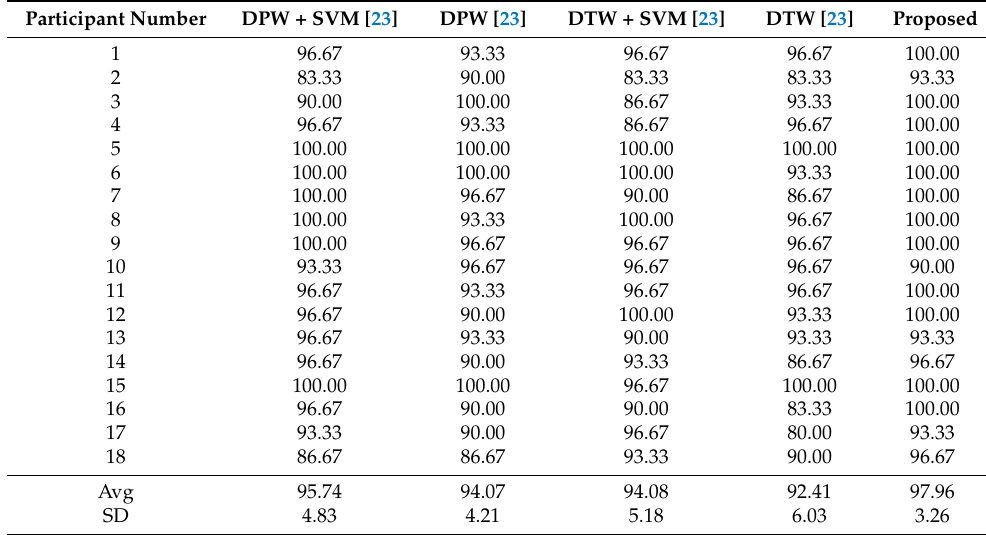
Table 3. Recognition accuracy for each participant with different classifiers.